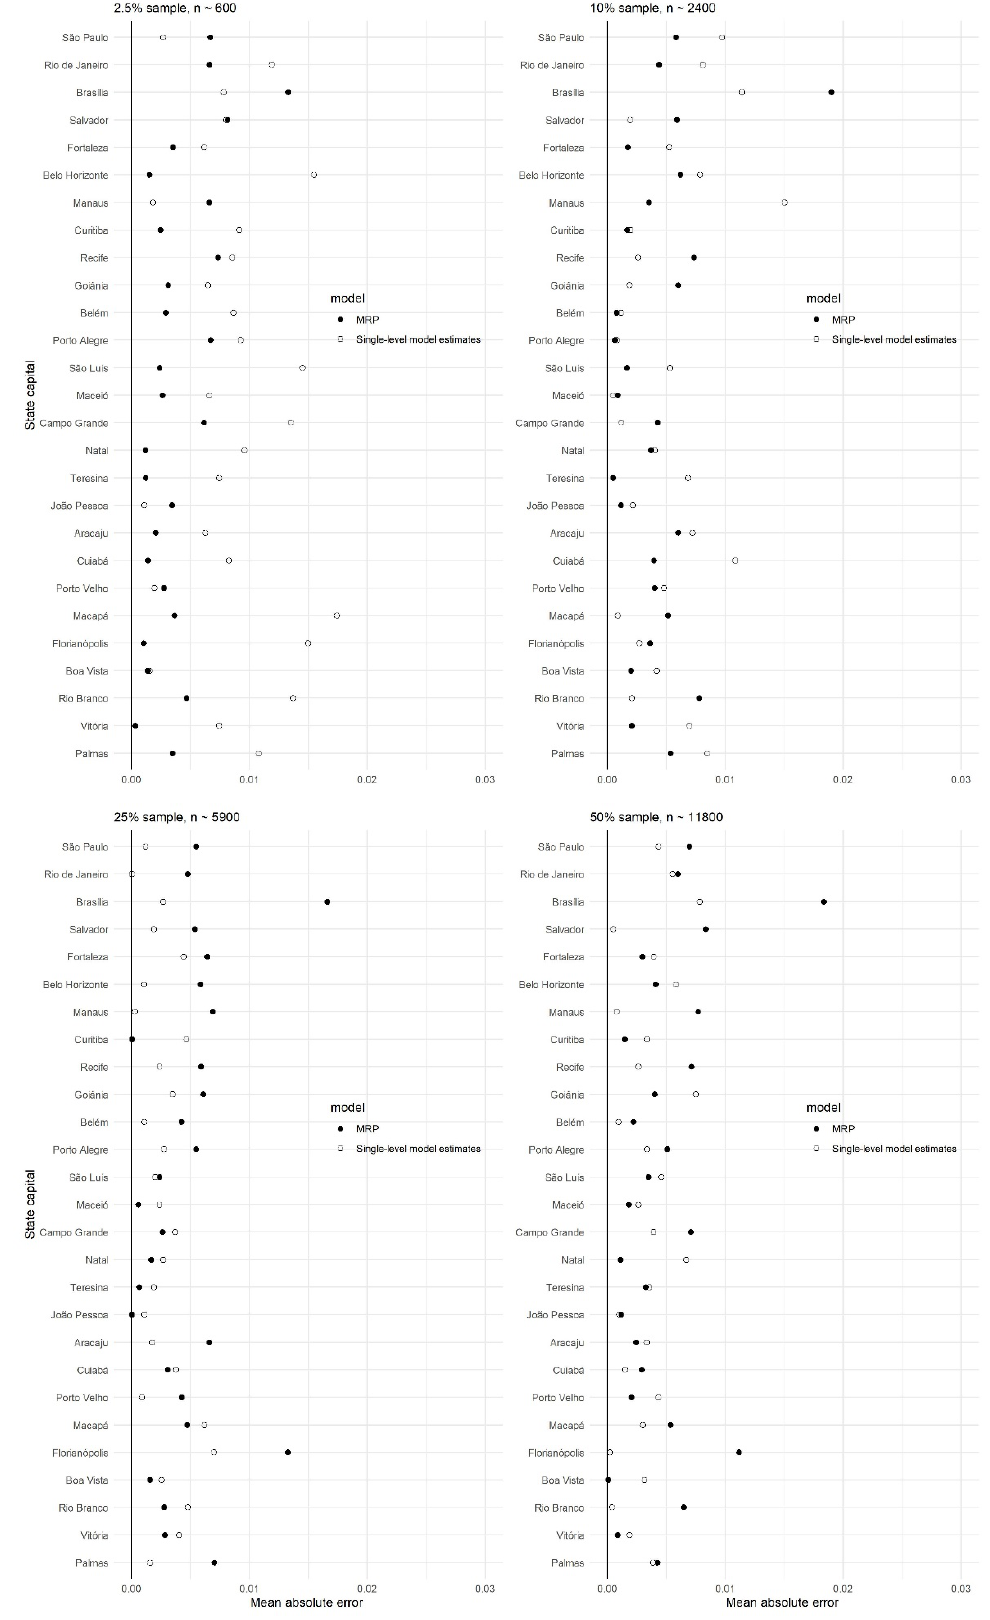
Figure 2. Cross-validation—mean absolute errors by state capital.